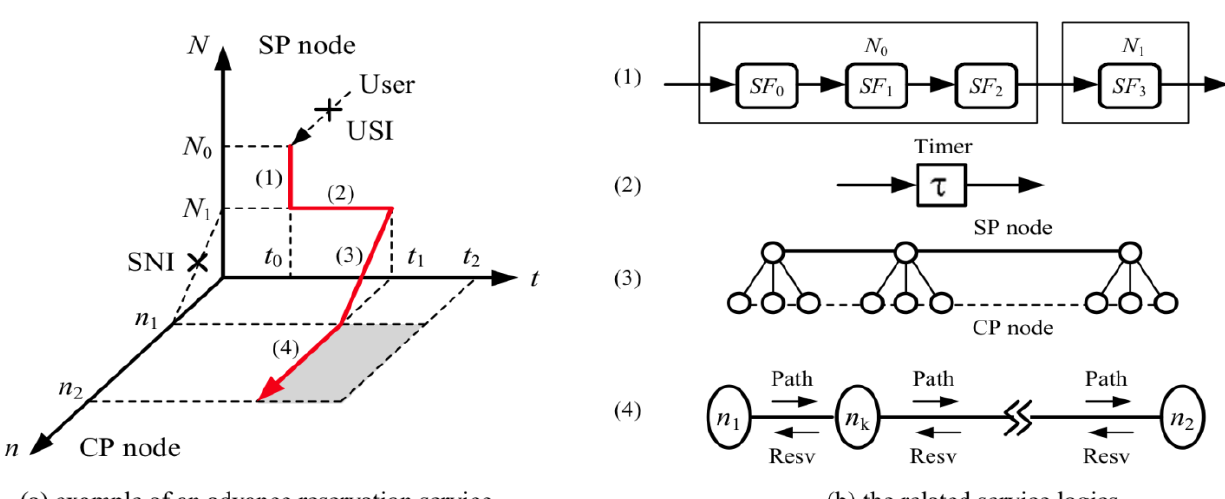
Figure 5. Adaptive decomposition of complex services. Extracted from